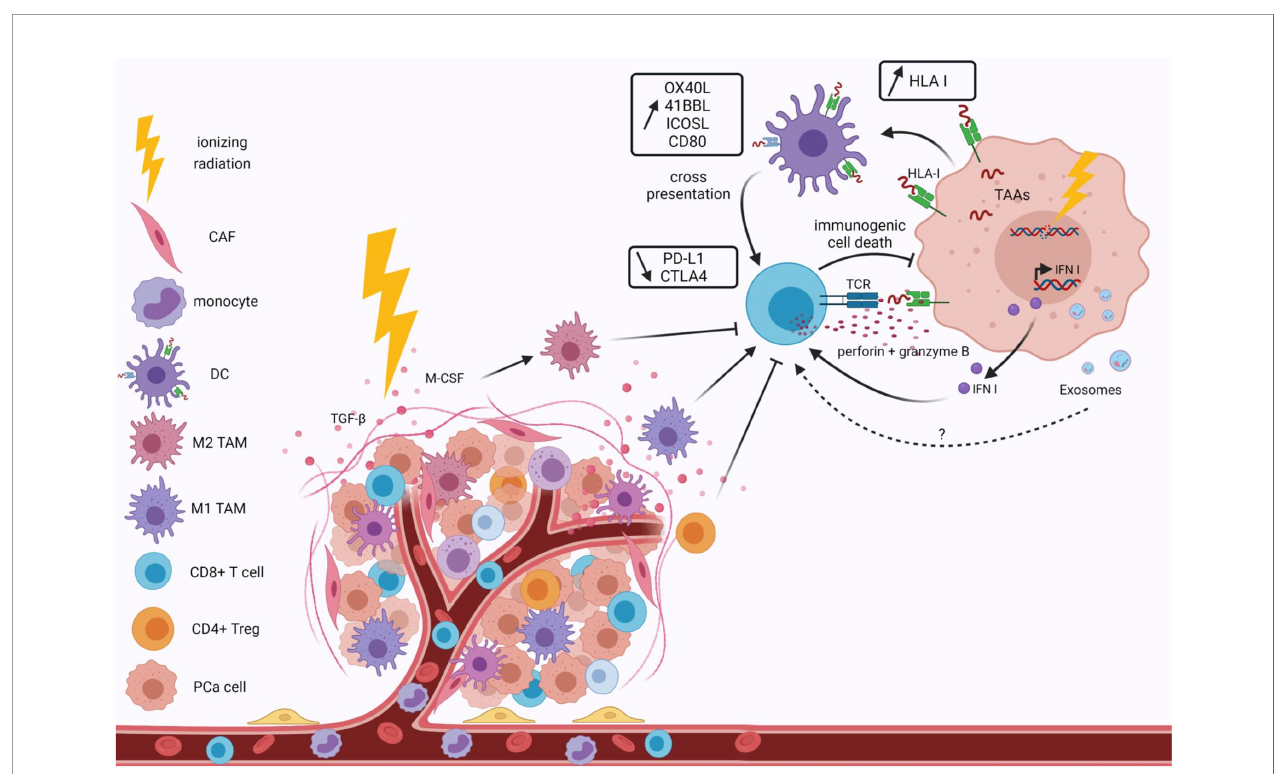
FIGURE 3 | Effects of ionizing radiation on the tumor immune microenvironment. Ionizing radiation modi fi es the tumor immune microenvironment by recruiting anti- tumor cells. Irradiation remodels the irradiated vasculature to enhance lymphocyte in fi ltration at the tumor site and macrophage polarization. Irradiation induces DNA damage, leading to the release of tumor-associated antigens, enhanced HLA I expression and type I IFN. An increase in T cell costimulatory molecules and a decrease in inhibitory proteins are also observed after irradiation. This results in immunogenic cell death of tumor cells. Immunosuppressive cells, such as M2 TAM or T reg, are also induced by irradiation due to their more radioresistant phenotypes. They induce suppression of the CD8+ cytotoxic T cell response. All these effects are dependent on the doses and fractionation of irradiation. Extracellular vesicle secretions and contents, notably in miRNAs, are affected by ionizing radiation. Exosomes are involved in tumor immune escape, but the irradiation effects on the promotion of the anti-tumor immune microenvironment of PCa through Evs remain to be addressed. HLA I, human leukocyte antigen; TAA, tumor-associated antigen; IFN I, Type I interferon; TCR, T cell receptor; CAF, cancer associated fi broblast; DC, dendritic cell; TAM, tumor-associated macrophage; PCa, prostate